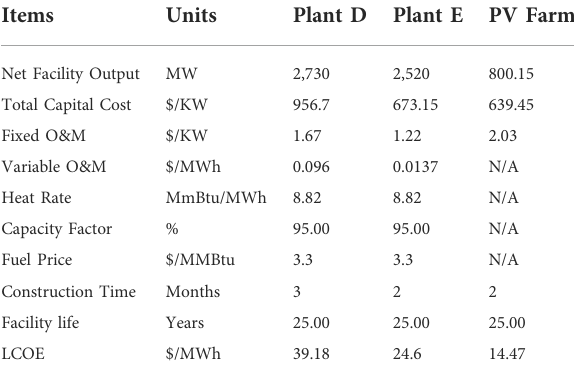
TABLE 3 Comparison between two newest conventionalgeneration and PV